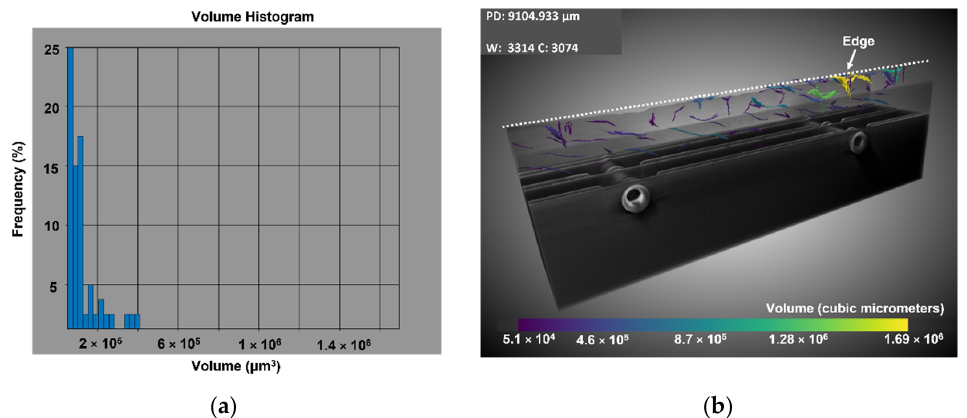
Figure 7. ( a ) Volume histogram of the cracks shown in Figure 6; ( b ) cracks with the same volume are shown with the same color.